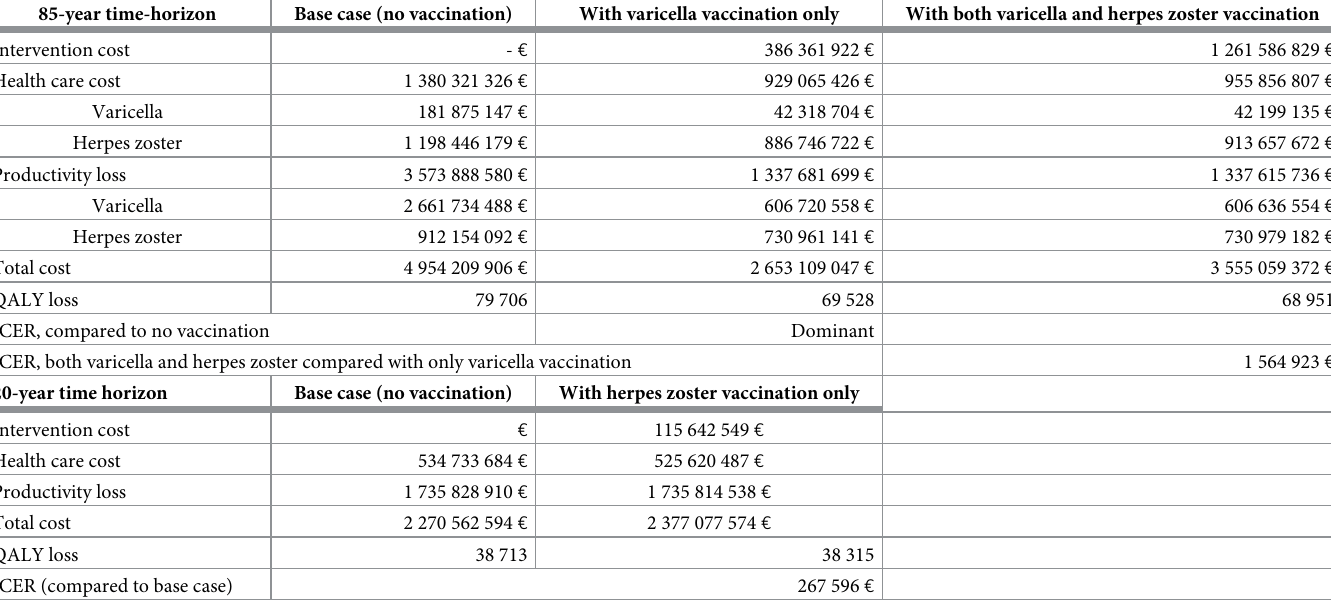
Table 4. Results from the cost-effectiveness analyses. The total costs for health care use, production losses, intervention cost, and the QALY loss for each scenario and its related cost per gained QALY (ICER) in comparison to no vaccination and the incremental analysis between varicella only and the combined programme.